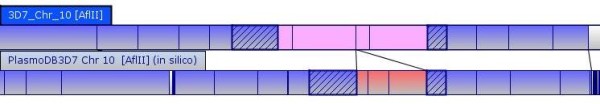
Chromosome 10 Duplication of PfEMP1; The segmental duplication observed in Figure 3 is located on chromosome 10 and is potentially an exact duplication of the gene PfEMP1.